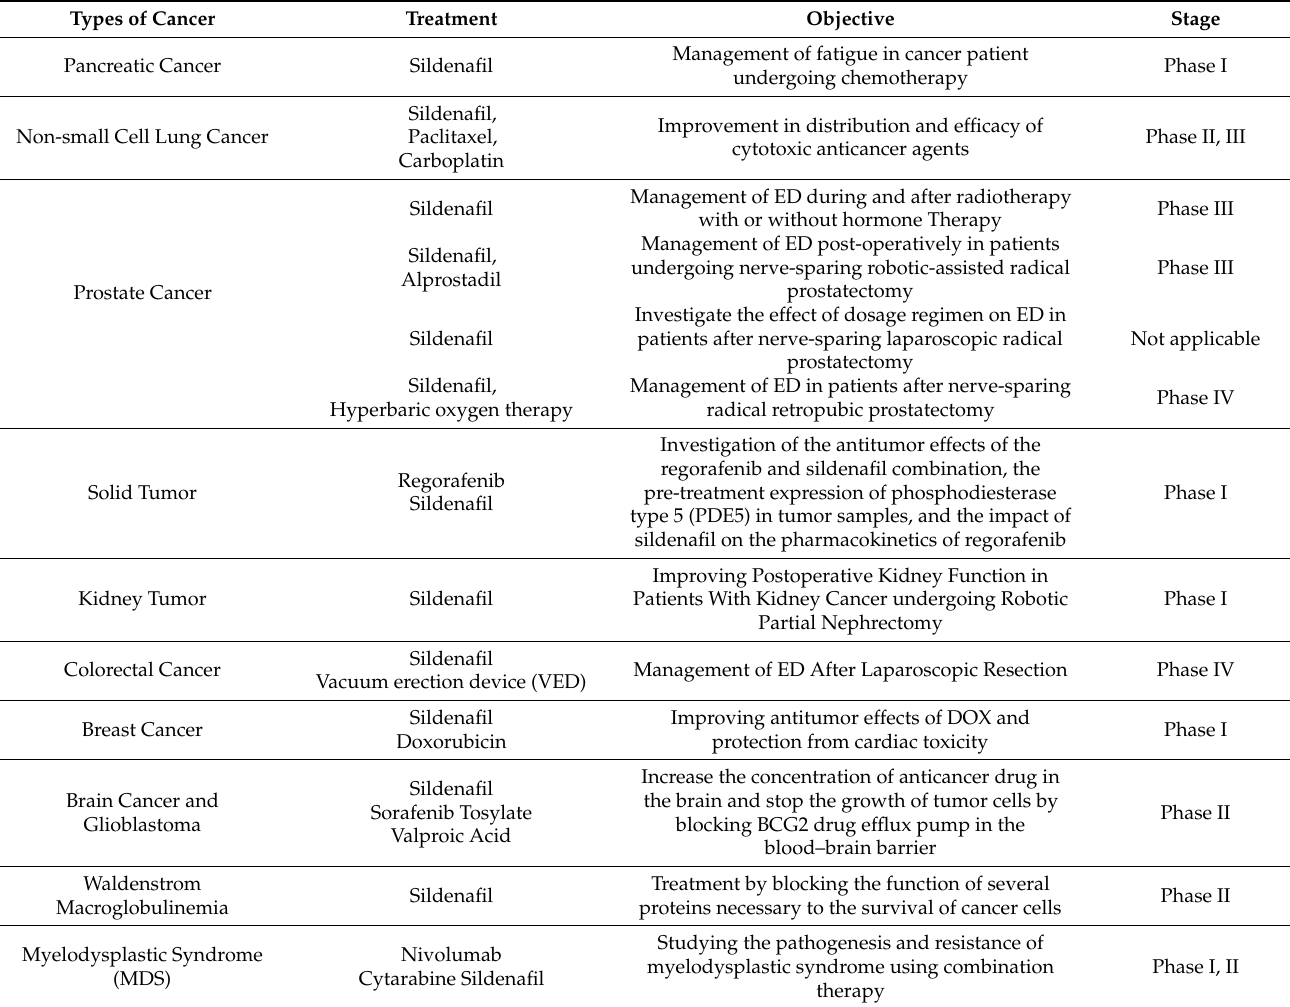
Table 2. Examples of clinical trials using sildenafil in treatment of different types of cancers